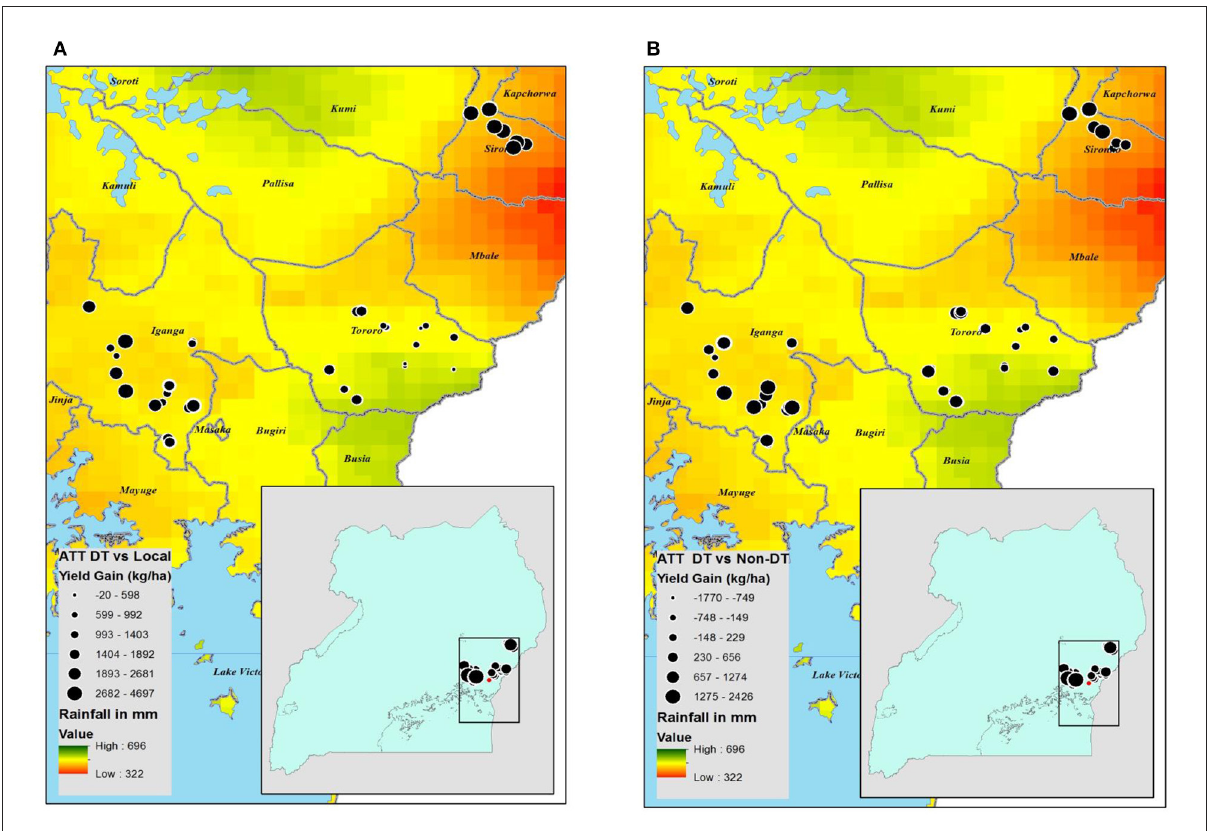
FIGURE3 (A) Spatial distribution of ATT (average treatment effects) of DT maize compared to local varieties. (B) Spatial distribution of ATT (average treatment effects) of DT maize compared to all non-DT varieties.